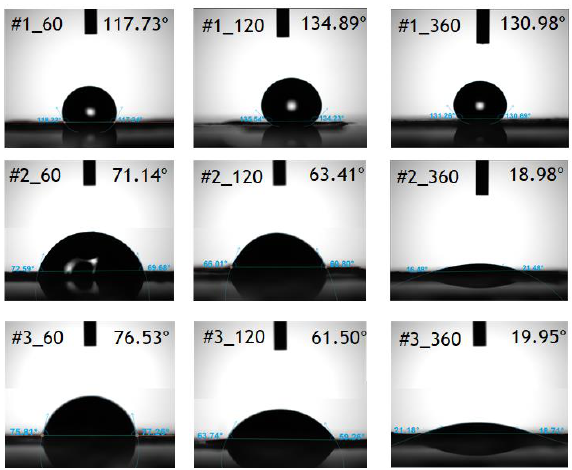
Figure 4. The contact angle of the surface of the porous PTFE substrate (Zeus) treated by GA and APTES ( #1 ) at the first row, GA and TMPEDA ( #2 ) at the second row, and GA and TMPDETA ( #3 ) at the third row with the incubation time of 60, 120, and 360 min from the left-hand side, respectively.